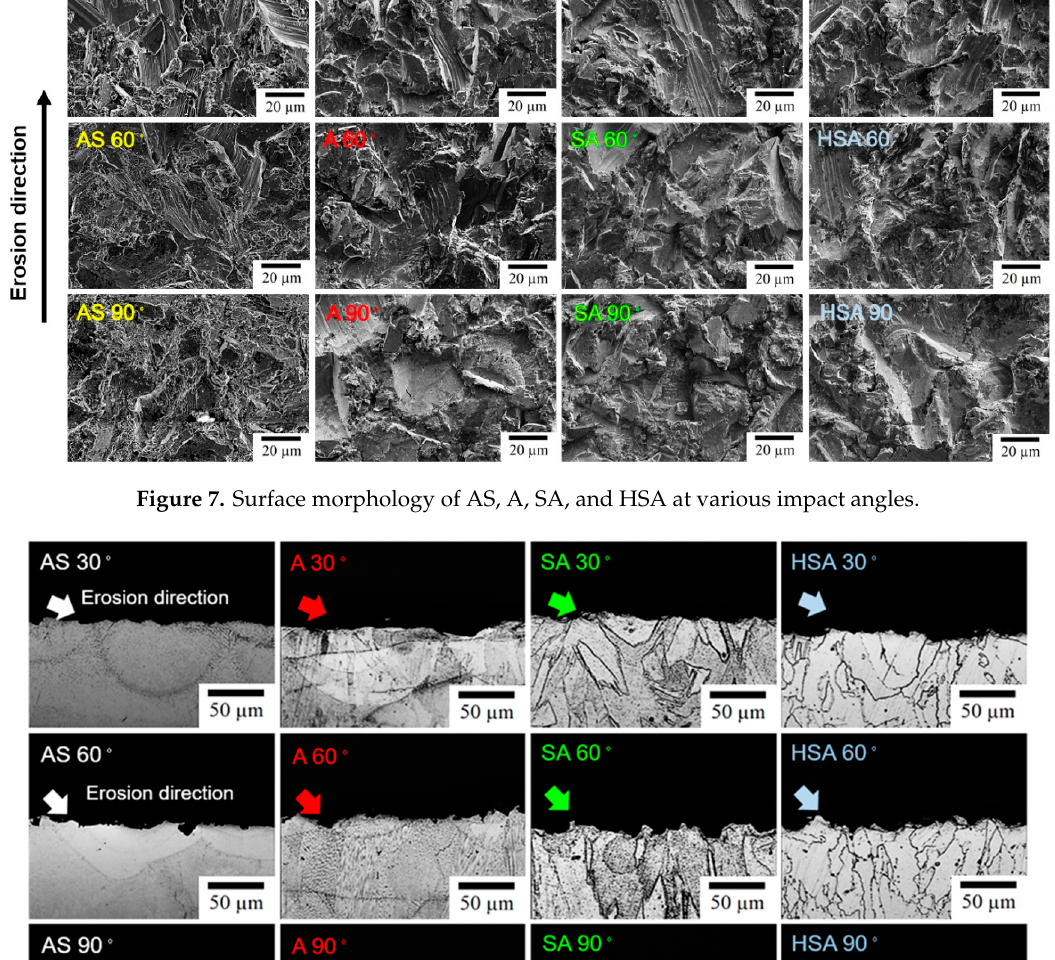
Figure 7. Surface morphology of AS, A, SA, and HSA at various impact angles.